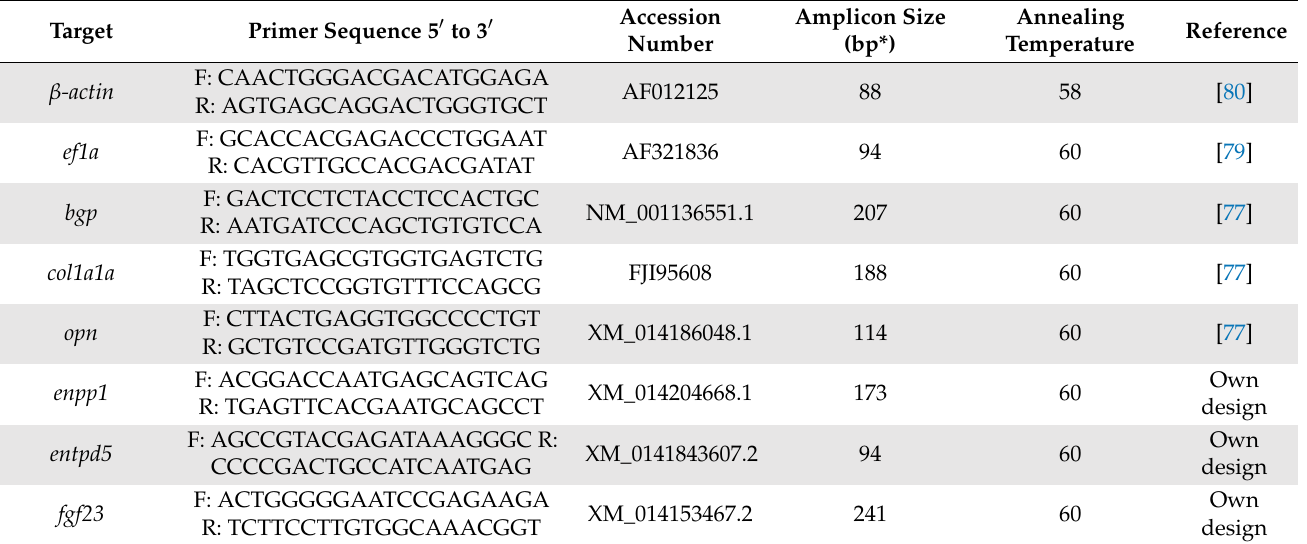
Table 2. Primer pairs used to amplify reference genes and genes of interest in real time